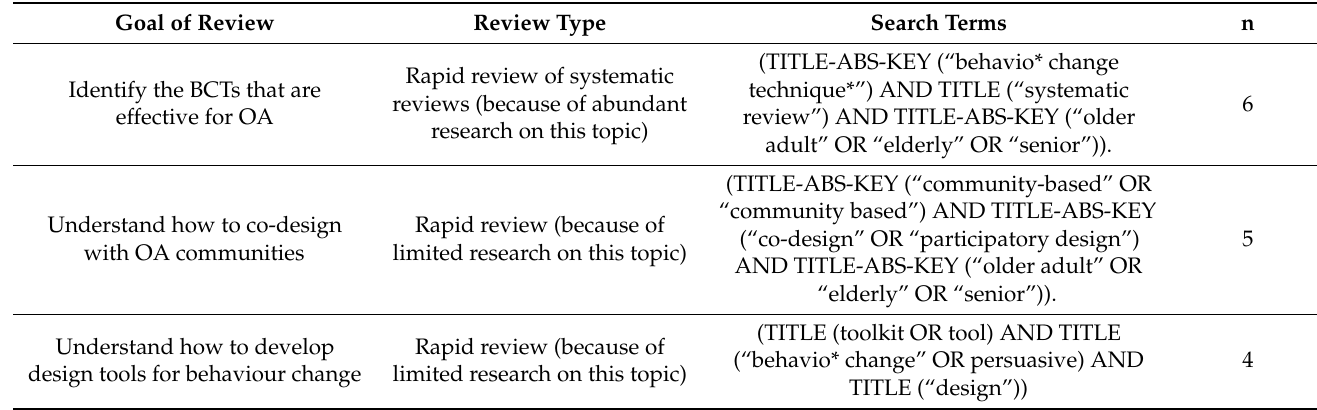
Table 1. Summary of the three rapid review searches (n: studies